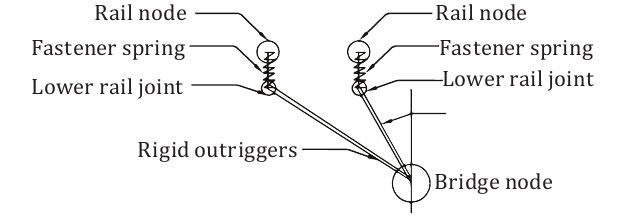
Figure 2. Layout of bridge track connection